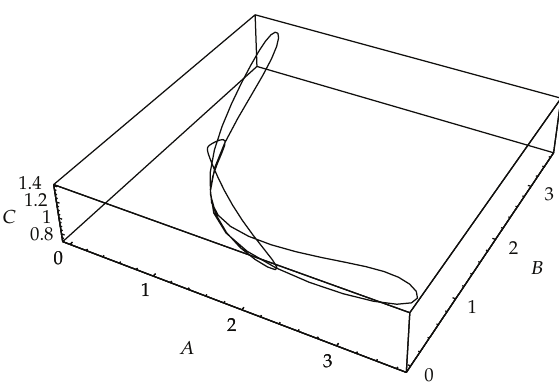
Figure 5: The evolution of A,B,C accordingly to (cid:2) 3.11 (cid:3) , t ∈ (cid:4) 0 , 2 π (cid:5) .